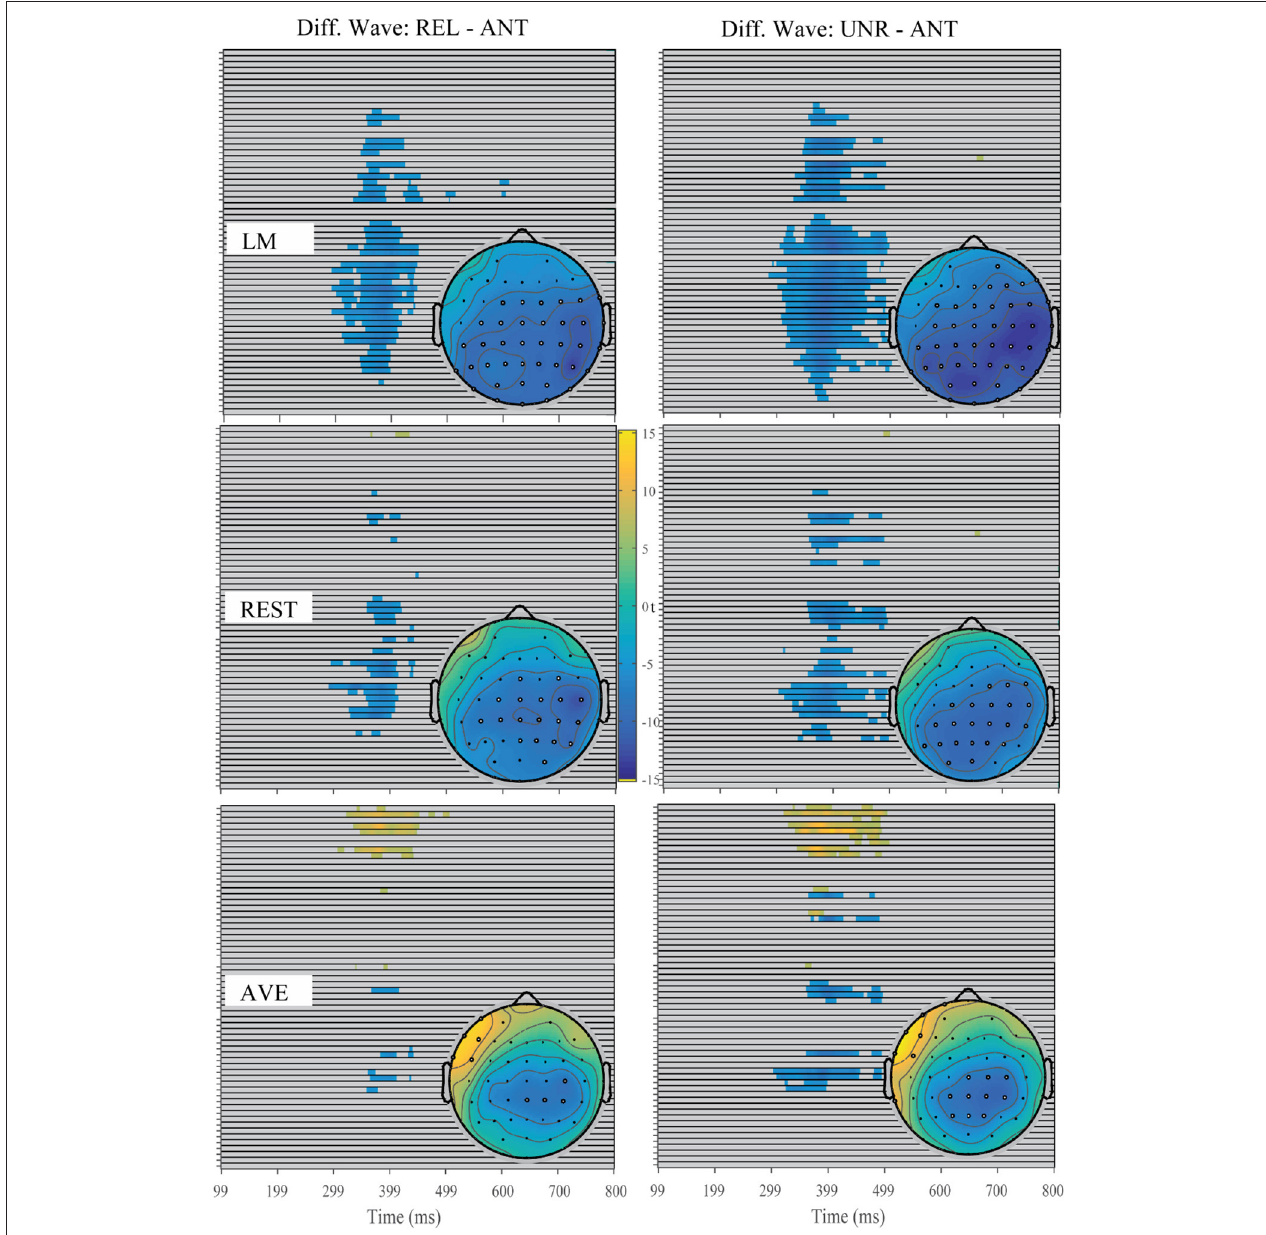
FIGURE 5 | Raster diagram illustrating the significant N400 effects according to the t -test permutation tests using three reference approaches. Blue and yellow rectangles indicate the time points and electrode sites at which the ERP effects are significantly smaller and larger than zero, respectively. Gray rectangles indicate the time points and electrode sites at which no significant differences were found. The inset topographical maps reveals the corresponding t -value maps at 370ms for each experimental condition and each reference approach. The white electrode indicates the significant N400 effect at that site while the black electrode indicates no significance at that